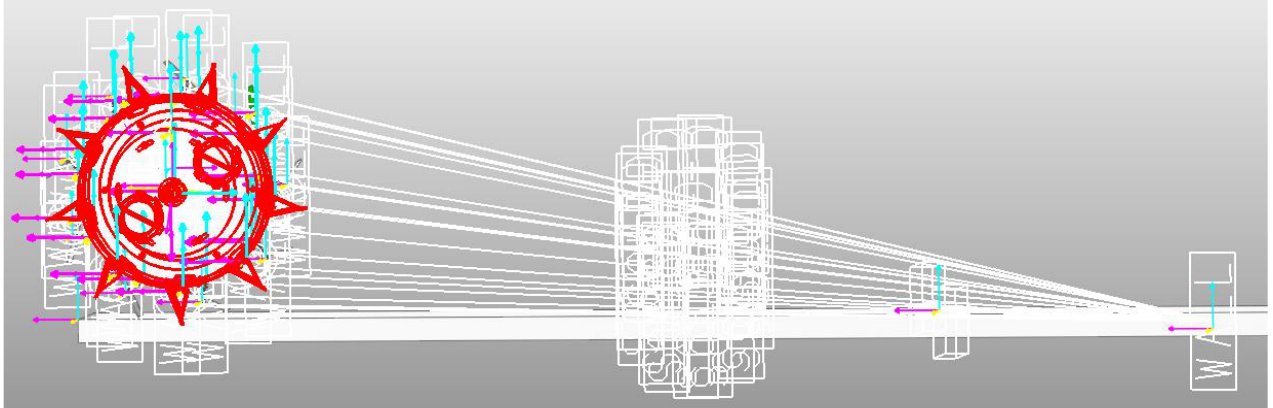
Figure 9. RecurDyn dynamics simulation model.